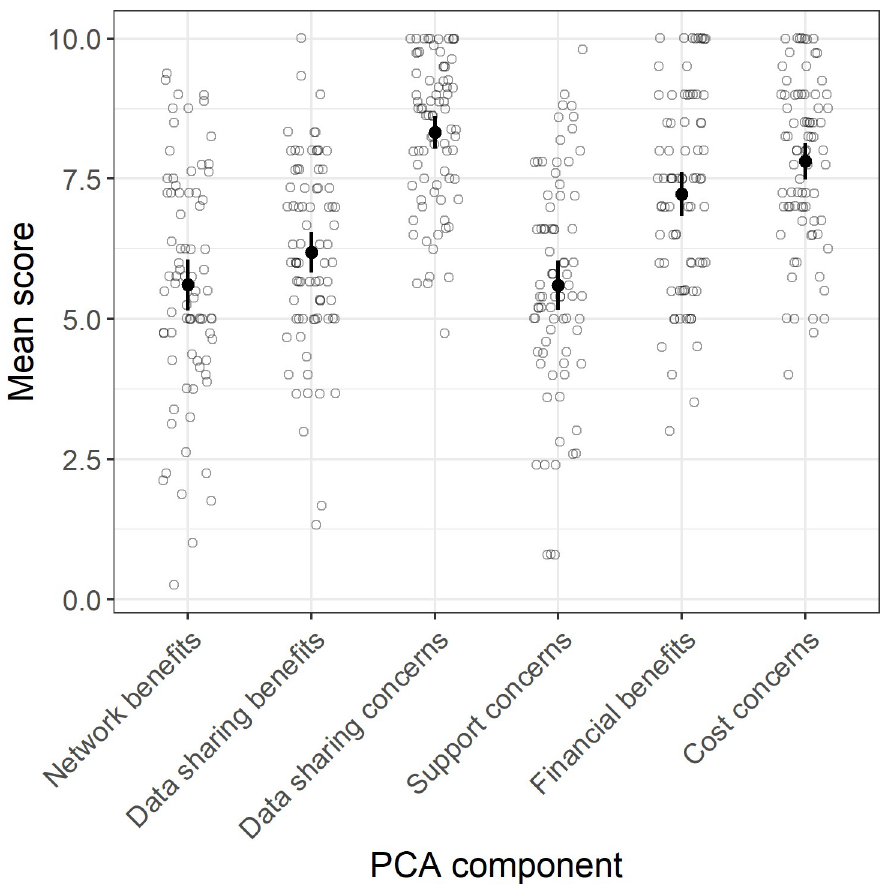
Fig 2. Individual scores (grey) and mean ± 95% confidence limits of scores across respondents (black) for each of six PCA components. A score of 0 suggests respondents perceived either no benefit or no concern, and a score of 10 suggests respondents perceived either great benefit or great